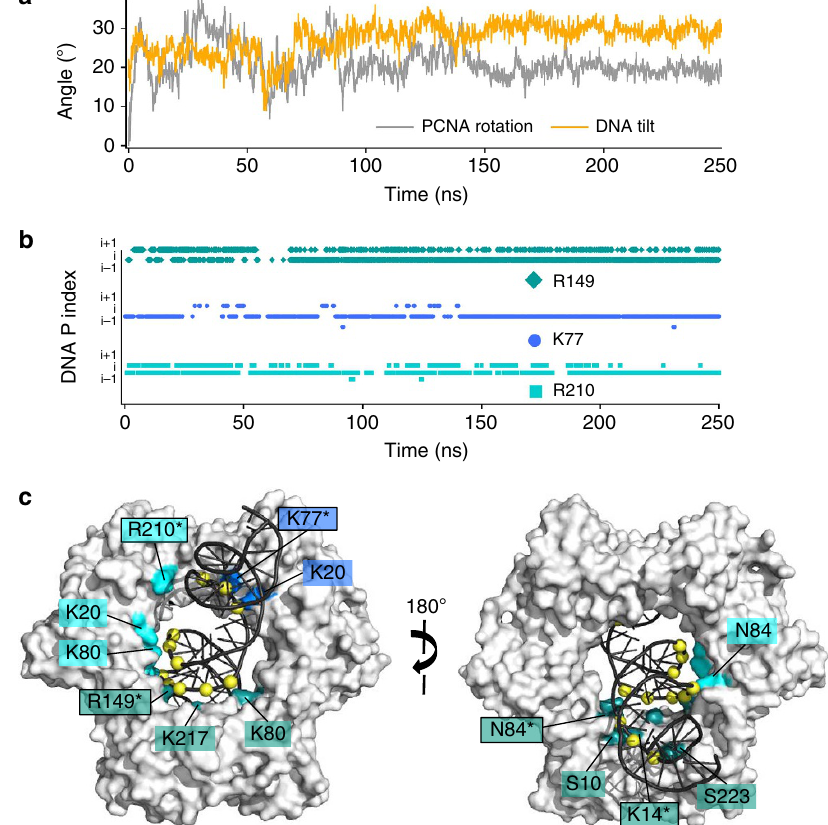
Figure 2 | MD simulation of human PCNA bound to a 30bp DNA. ( a ) PCNA ring rotation and evolution of DNA tilting relative to the ring C3 axis ( b ) Time evolution of contacts between the side chain nitrogens of three representative PCNA interfacial residues and DNA phosphorus atoms at consecutive positions ( c ) Two views of the PCNA–DNA complex at the end of the MD trajectory. PCNA is shown as a grey surface and DNA as a black ribbon. PCNA residues whose side chains are engaged in polar contacts with DNA phosphates for 4 25% of the MD trajectory are labelled. Residues from different PCNA subunits are coloured in shades of blue. Residues that exchange between two or three consecutive DNA phosphates for 4 75% of the MD simulation are indicated by an asterisk and